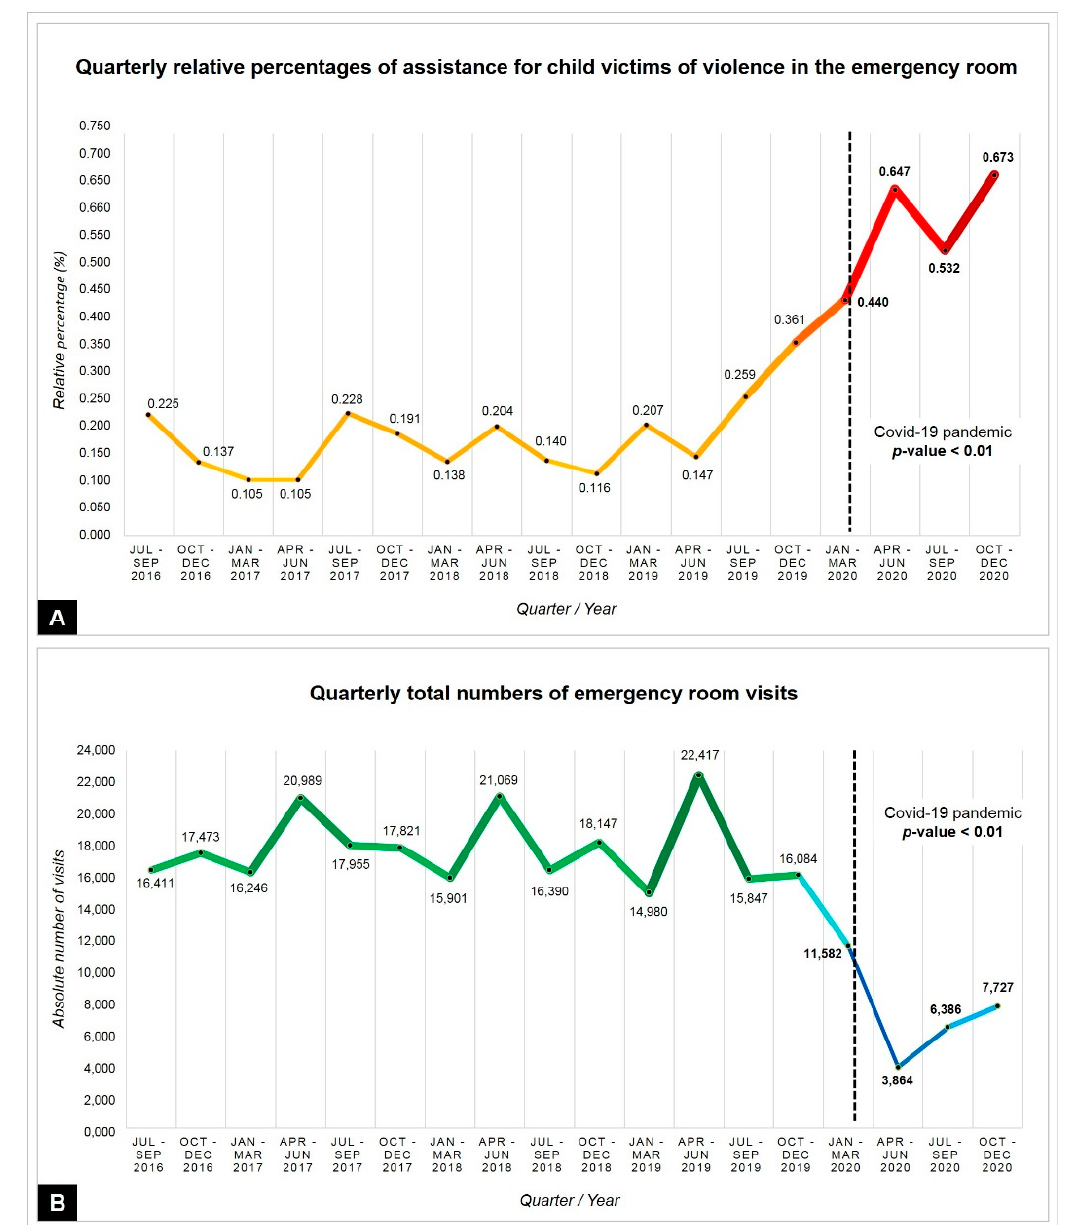
Figure 3. Indicators of emergency room visits. ( A ) Quarterly relative percentage of the number of visits due to violence; in red color and thick line, representation after the start of the pandemic by COVID-19. ( B ) Absolute numbers of emergency room visits; in blue color and thin line, representation after the start of the pandemic by Covid-19.